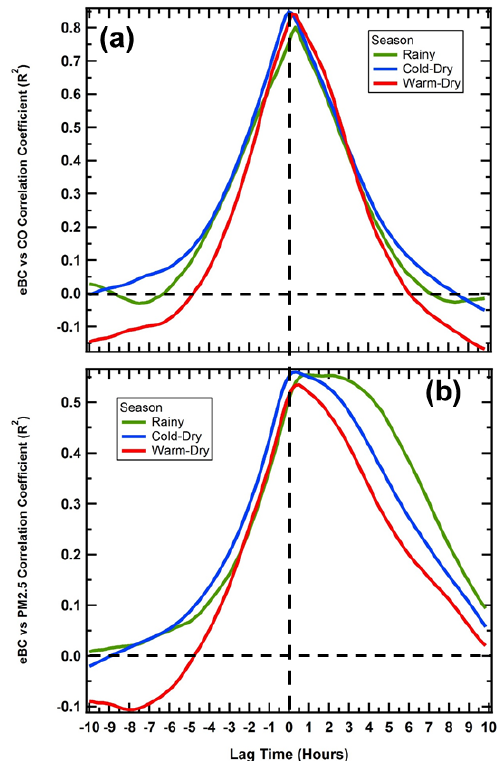
Figure 13. As in Fig. 12, these plots illustrate the correlations be- tween (a) Bscat and PM 2 . 5 and (b) eBC and SSA, as a function of the lag time and differentiated by